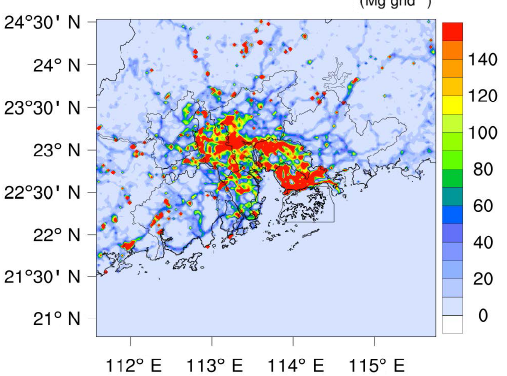
Figure 4. Spatial distribution of total S–IVOC emissions for the year 2010.